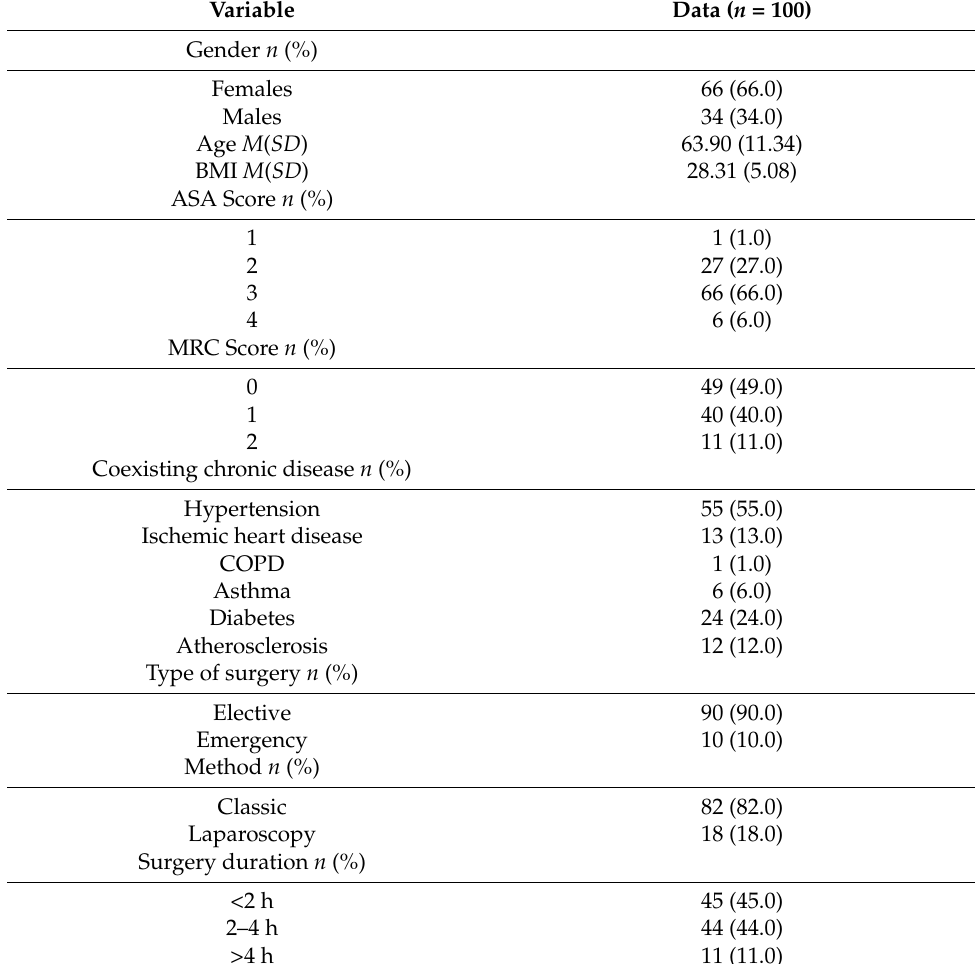
Table 1. Clinical characteristics of study